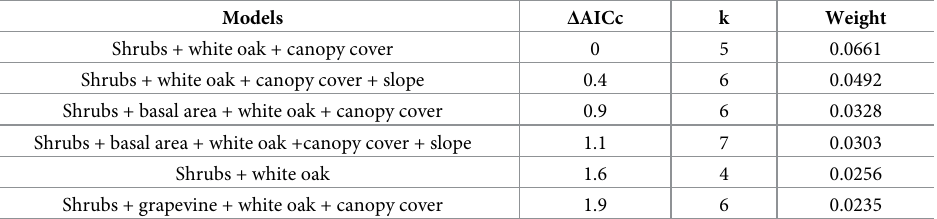
Table 3. Top models for presence of Cerulean Warbler roost sites. Top 6 models selected for presence of roost loca- tions of Cerulean Warblers ( Setophaga cerulea , Wilson) in southern Indiana in May-June 2017, with AICc values, degrees of freedom, and weights. Models Δ AICc k Weight Shrubs + white oak + canopy cover 0 0.0661 Shrubs + white oak + canopy cover + slope 0.4 Shrubs + basal area + white oak + canopy